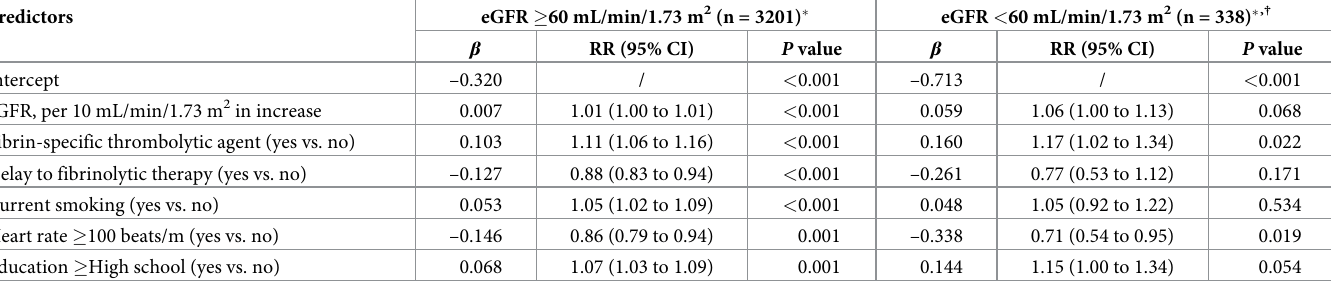
Table 4. Prediction models for successful fibrinolysis in patients who received fibrinolytic therapy among patients with and without reduced kidney function (eGFR < 60 mL/min/1.73 m 2 ).